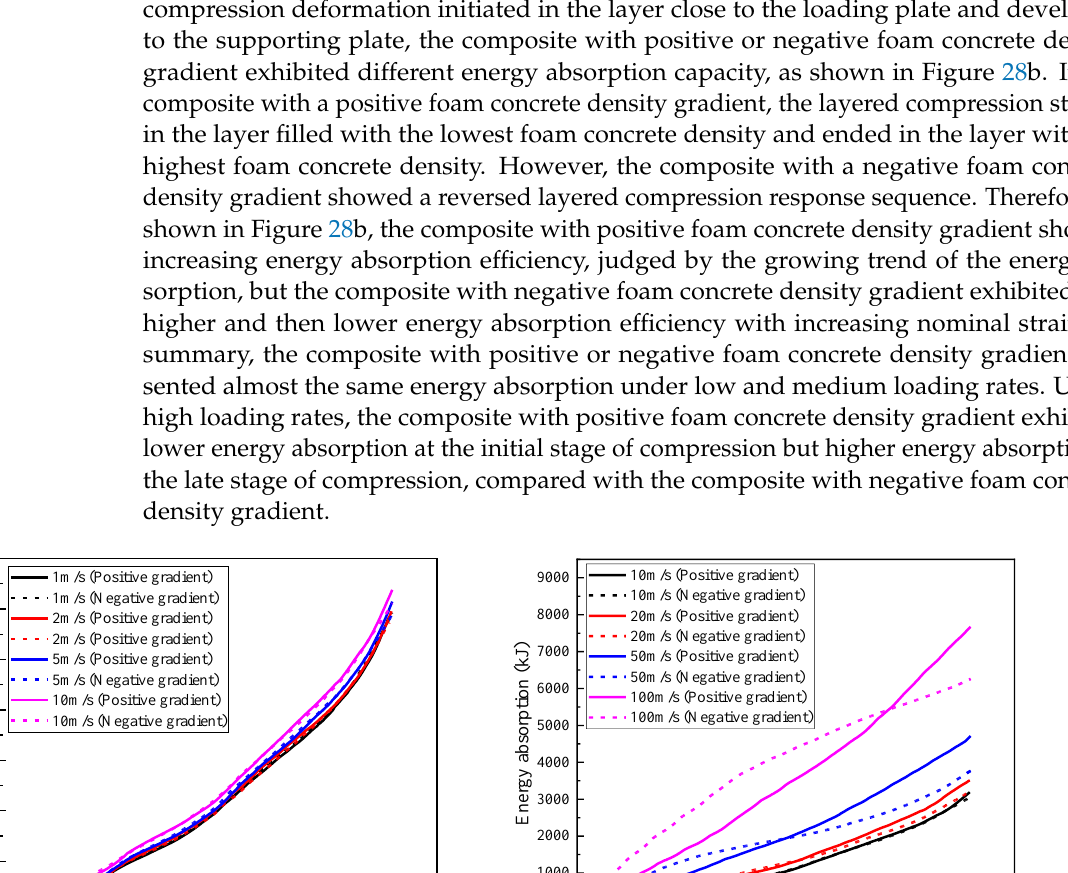
( b ) Figure 29. The representative points for effective Poisson’s ratio calculation: ( a ) numerical model; ( b ) representative points.